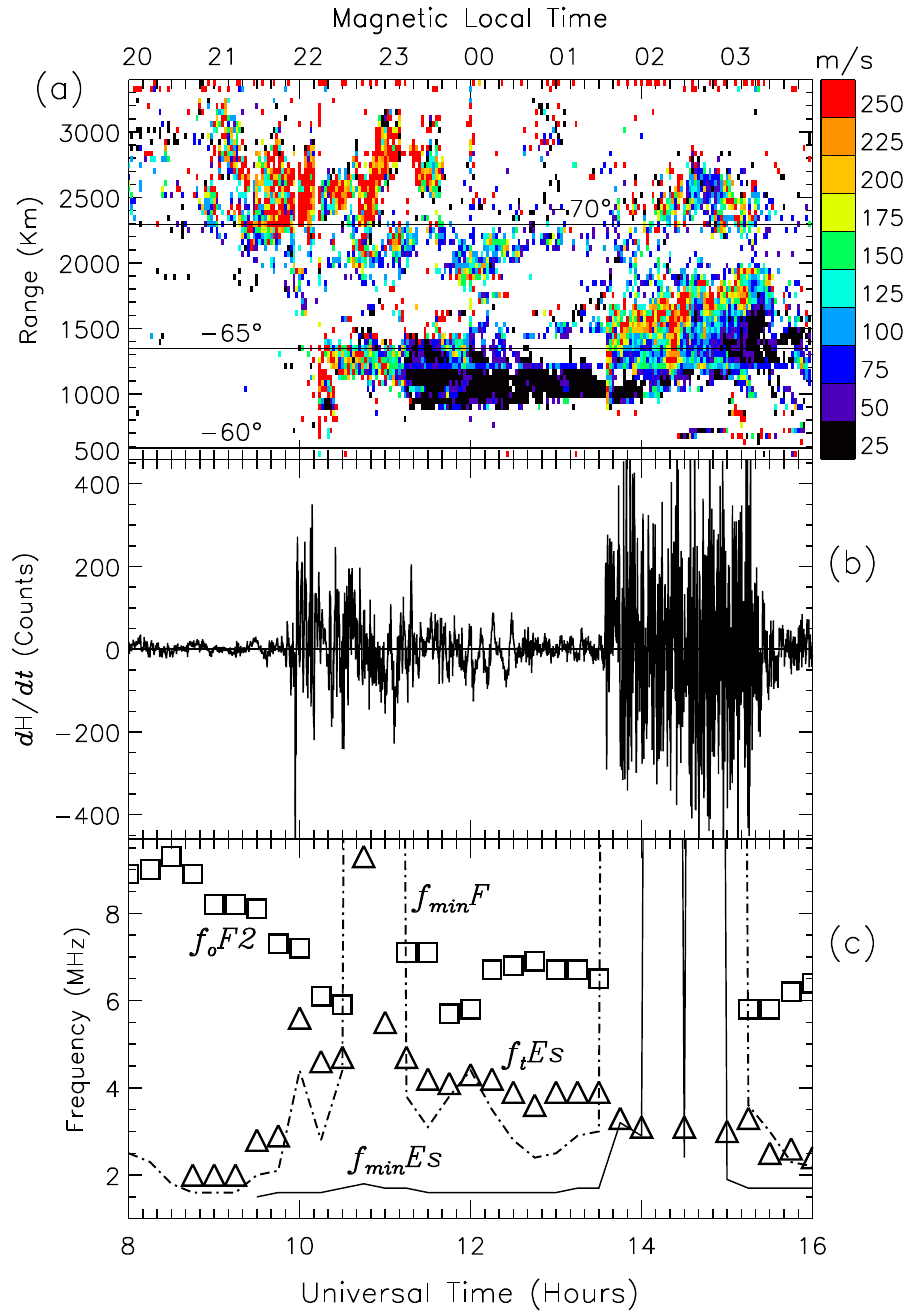
Fig. 7. (a) RTI plot of Doppler spectral width (ms − 1 ) recorded every 2min on TIGER beam 15 during 08:00 to 16:00UT on 27 February 2000. (b) The time derivative of the geomagnetic H component measured at 1-s intervals by an induction coil magnetometer located at MQI. (c) The critical frequency parameters f min Es (continuous line), f min F (dash-dot-dash line), f t Es (open triangles), and fo F2 (open squares), all scaled from routine ionograms recorded at 15-min intervals by an analogue ionosonde located at MQI. The abscissas have tick marks at 10-min intervals of UT, and nominal values of MLT at MQI are shown at